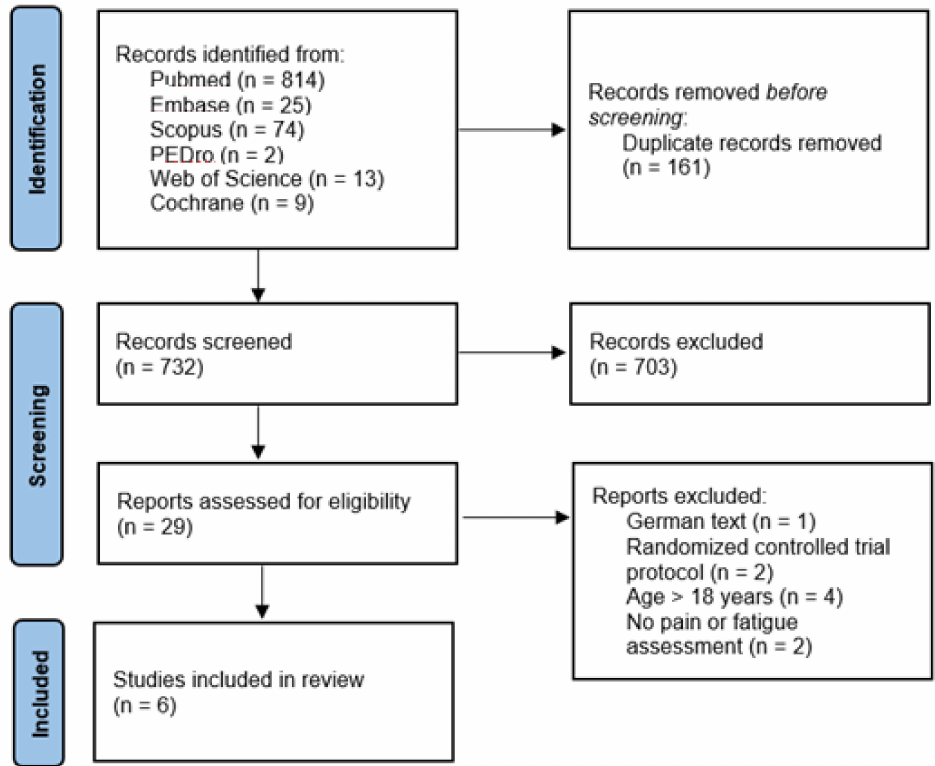
Figure 1. PRISMA flow